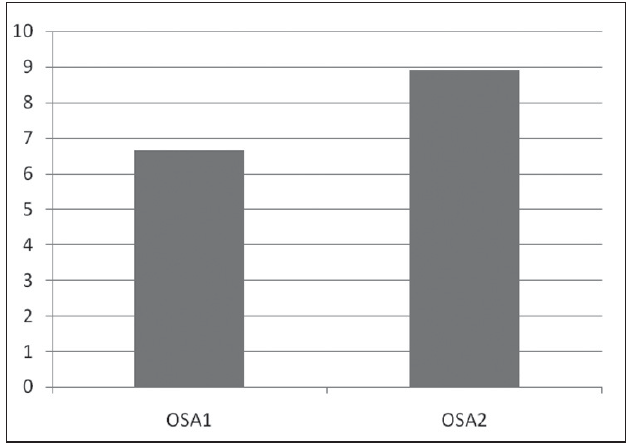
Fig. 1. Comparison between oral stereognostic ability on day 1 and after 6 months of denture